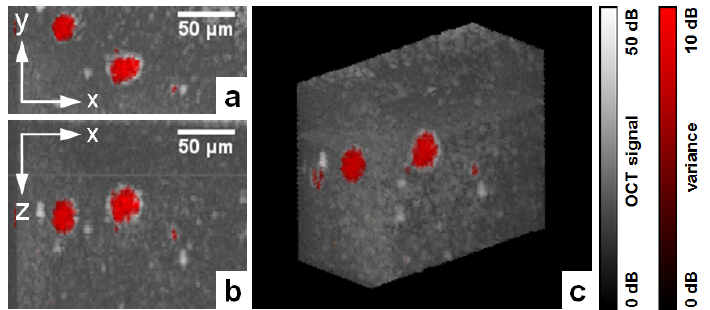
Figure 7. Volumetric rMM-OCT imaging of labeled ARPE-19 cells embedded in an agar scaffold. ( a ) Top view and ( b ) side view of a recorded 3D OCT image stack showing two cells next to each other. ( c ) 3D view of the two cells. All views represent maximum intensity projections of the 3D image data (color online).